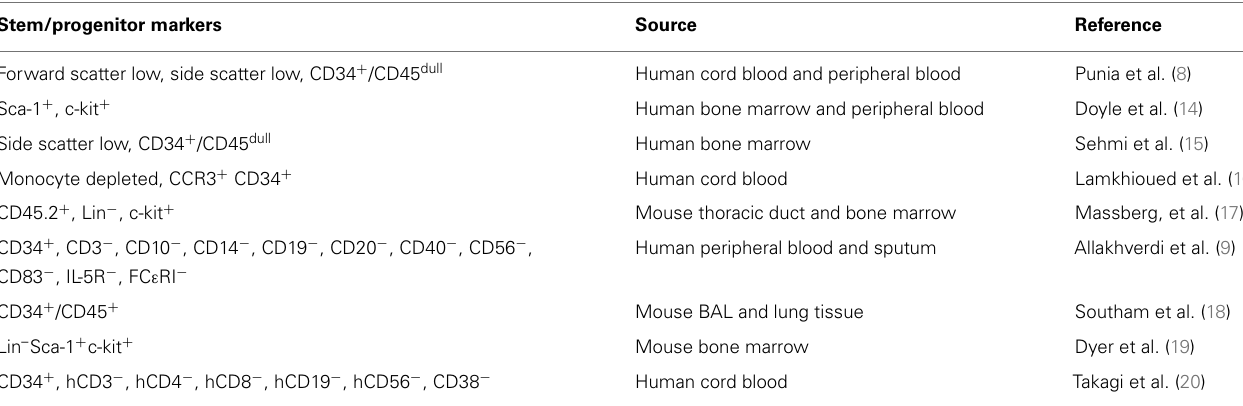
Table 1 | Classification and characteristics of stem/progenitor cell markers: reports examining the homing and differentiation of HSPCs utilize different markers and starting source materials .